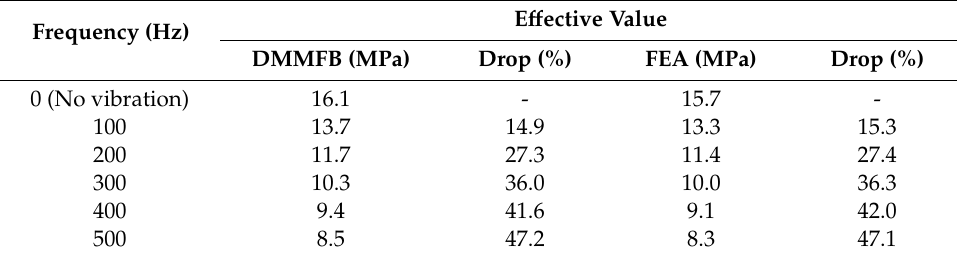
Table 3. E ff ective value of the pressure drop without and with 0.25 g vibration applied at di ff erent frequencies.